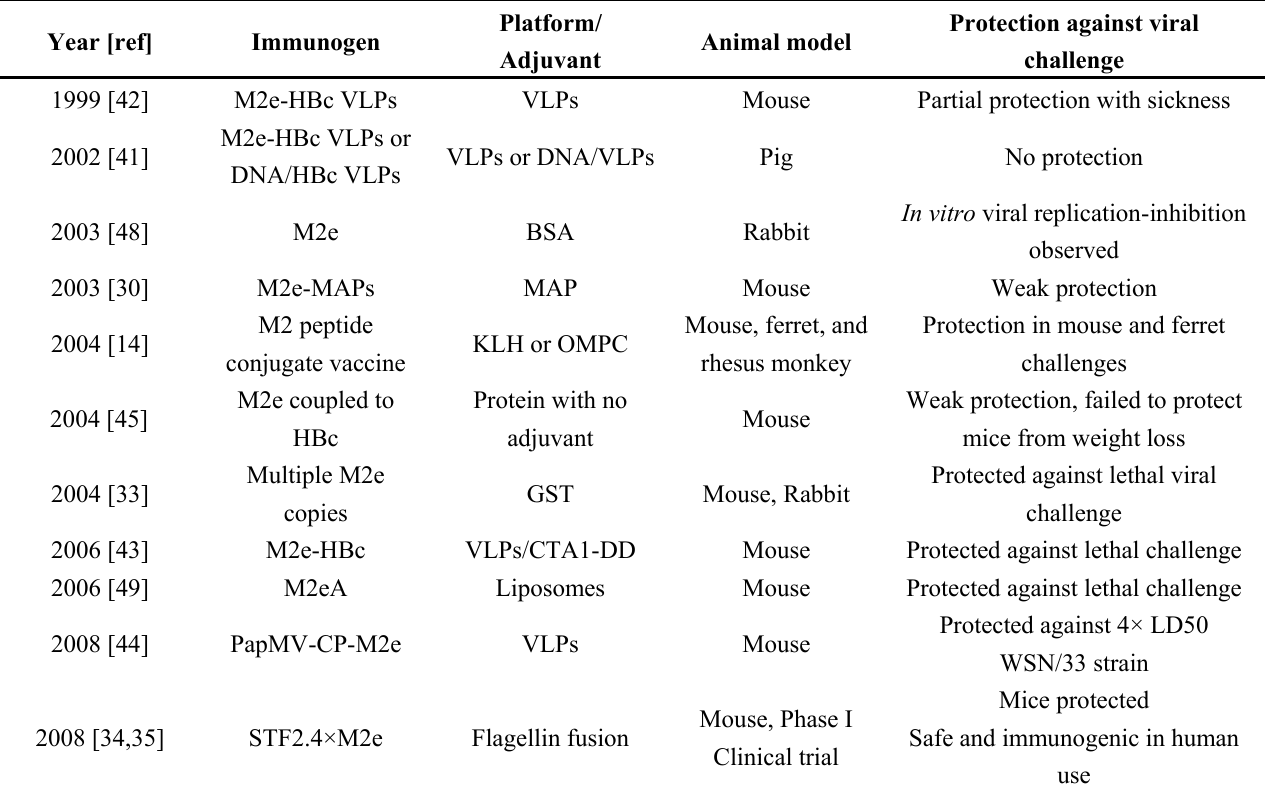
Table 2. Summary of M2e-based universal influenza vaccine